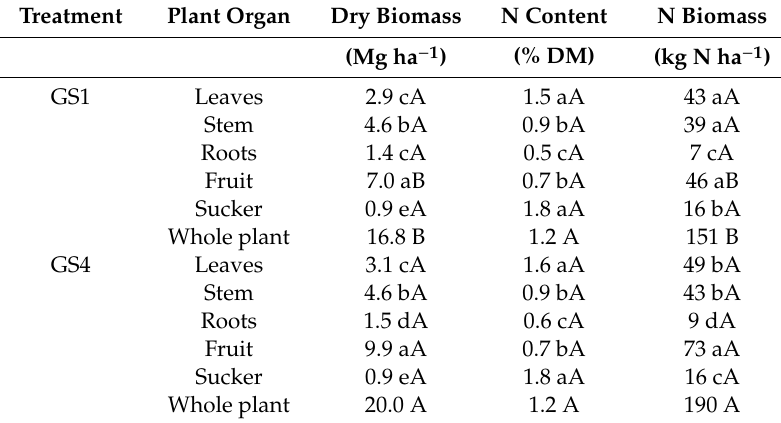
Table 1. Dry and N biomass allocation in plant organs at banana harvest. GS1 and GS4 refer to the first and the fourth growing seasons, respectively. Di ff erent lower-case letters indicate significant di ff erences between plant organs within each treatment, and di ff erent capital letters indicate significant di ff erences between treatments for each plant organ ( p ≤ 0.05, n = 8).